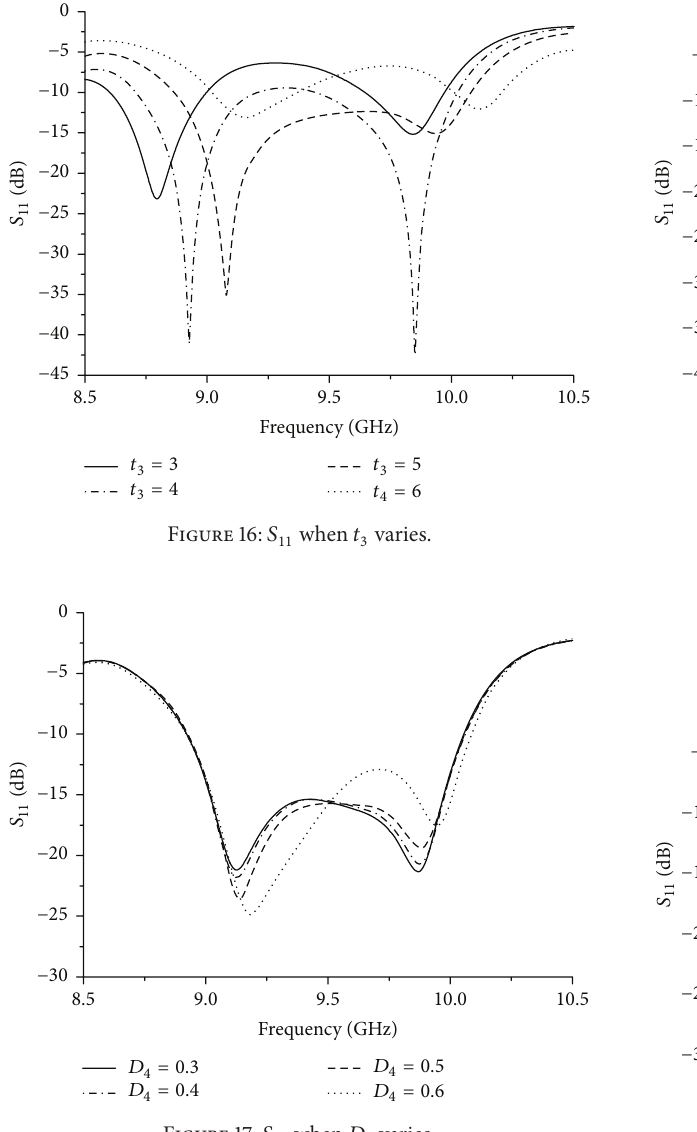
Figure 17: 𝑆 11 when 𝐷 4 varies.